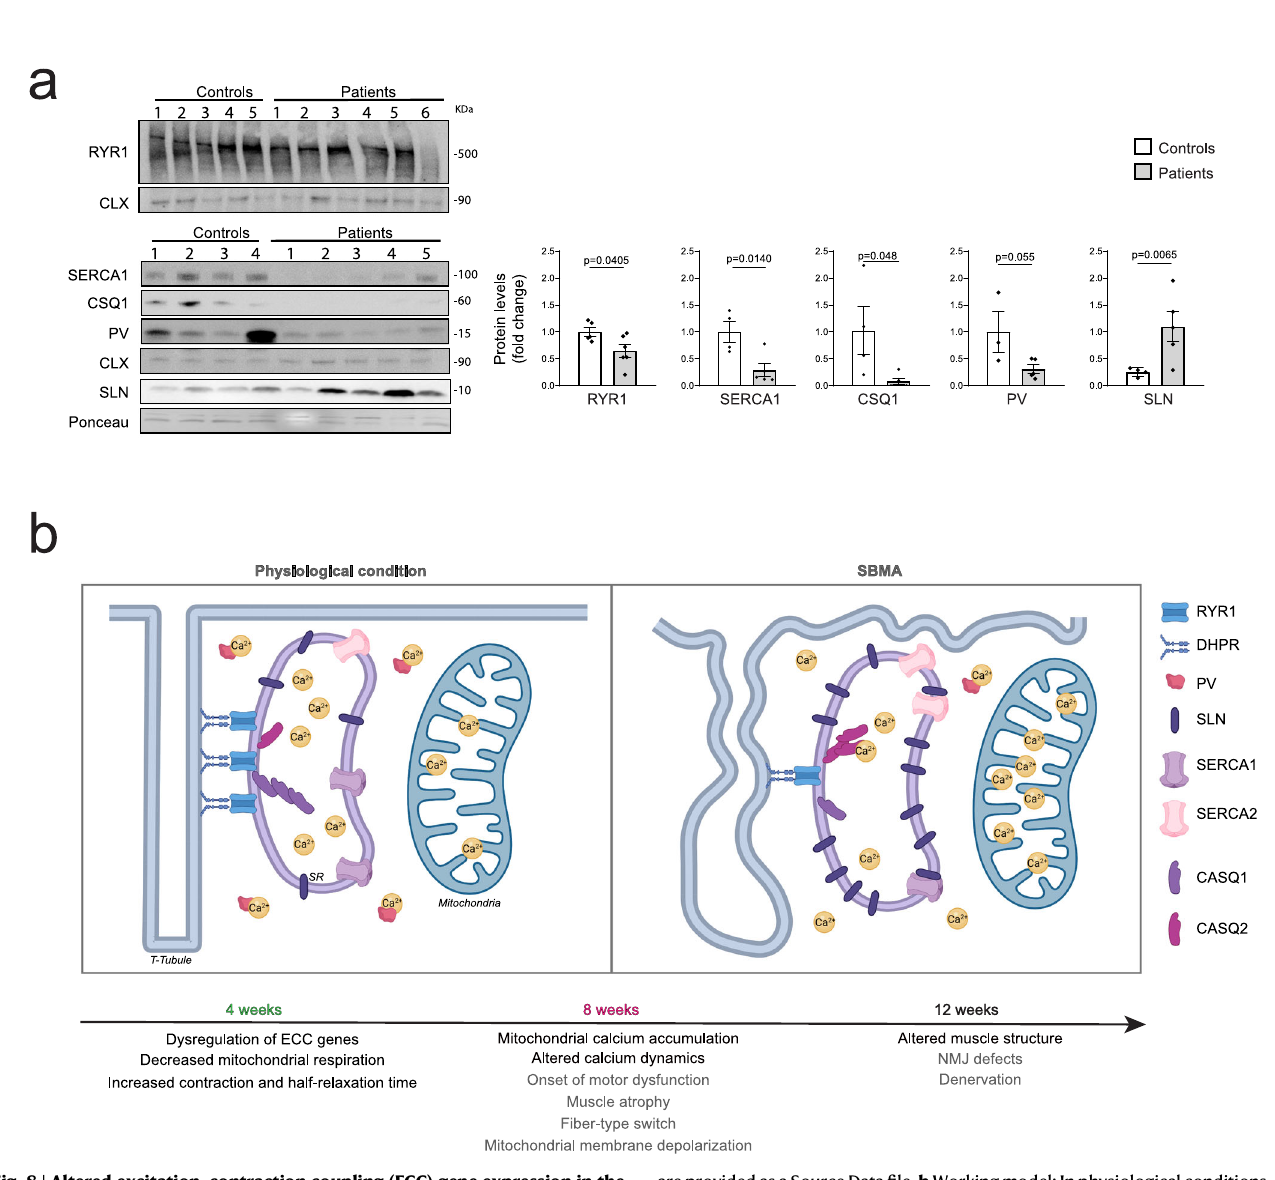
areprovidedasaSourceData fi le. b Workingmodel:Inphysiologicalconditions,PV in the cytosol and CASQ1/2 in the SR bind Ca 2+ . Sarcolemma depolarization results in a conformationalchange ofDHPR,which inturnleads to Ca 2+ ef fl uxthroughthe RYR1 from the SR to the sarcoplasm and into mitochondria. Ca 2+ then is pumped back to the SR by SERCA1/2, whose function is negatively controlled by SLN. In SBMA-affected muscles, the expression of ECC proteins is altered and Ca 2+ accu- mulates into mitochondria during muscle contraction as a function of disease progression.AgereferstoAR100Qmice.Ingray,pathologicalprocessespreviously characterized; in black major fi ndings shown here.